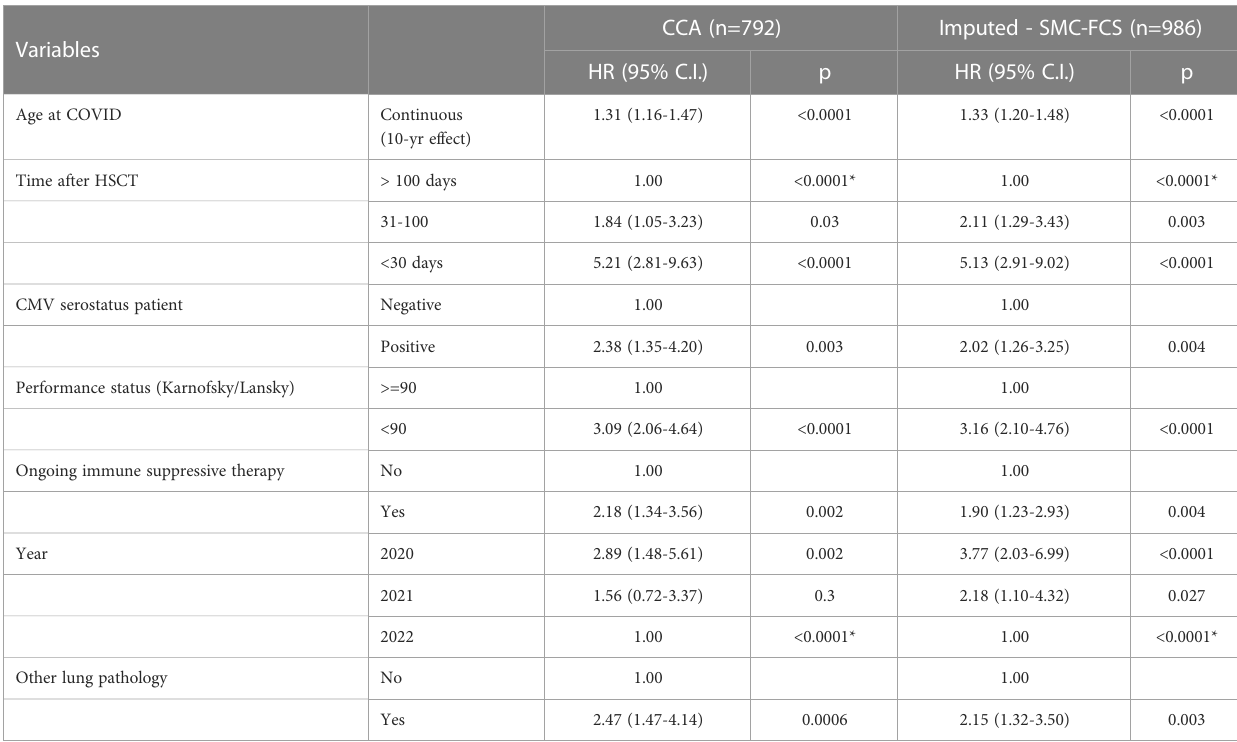
TABLE 2 Overall survival – Multivariate